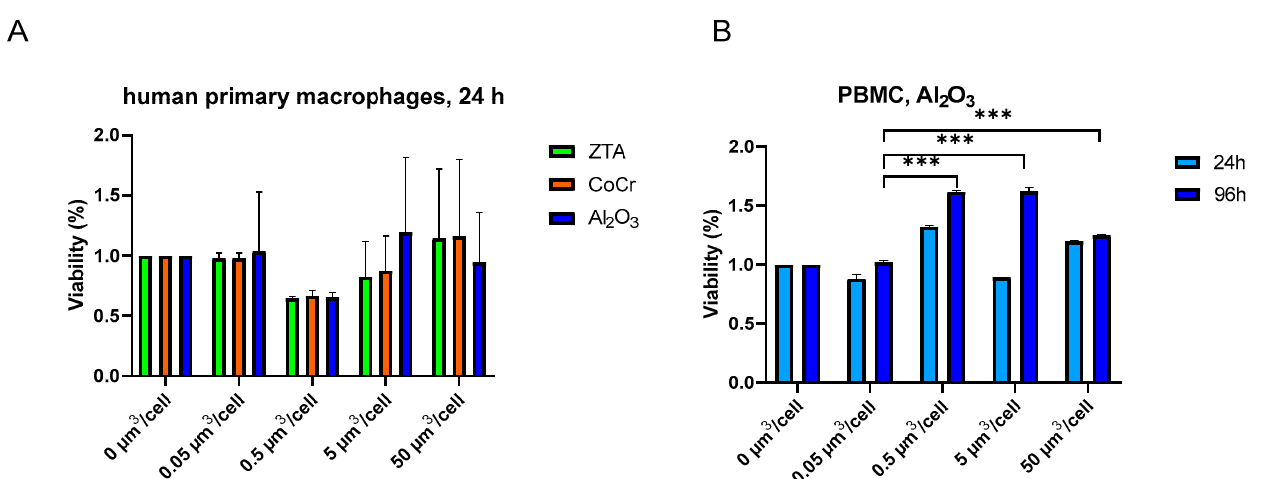
Figure 3. Viability of human primary macrophages is not impacted by ZTA or CoCr particles. Human primary macrophages were treated with Al 2 O 3 , ZTA, or CoCr particles, and viability of cells was measured by MTS 24 h after treatment ( A ). PBMCs were treated with Al 2 O 3 particles for 24 h or 96 h ( B ). The relative cell viability was calculated as the percentage of untreated cells. The results are expressed as the mean ± SEM.*** p ≤ 0.001.